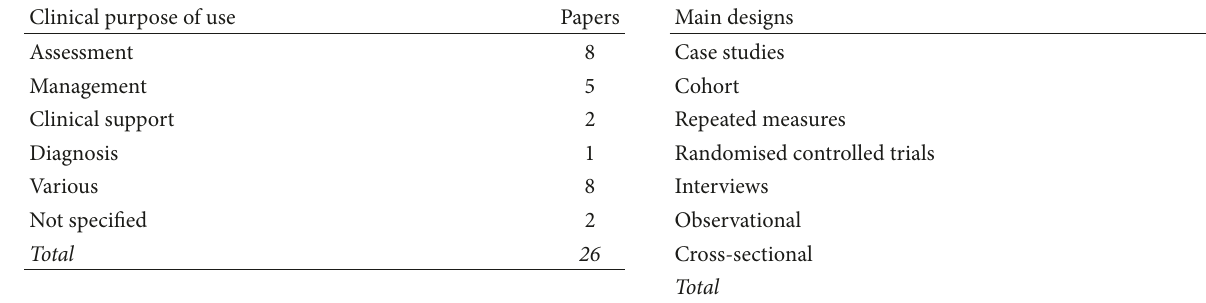
Table 2: Papers grouped by country of origin.